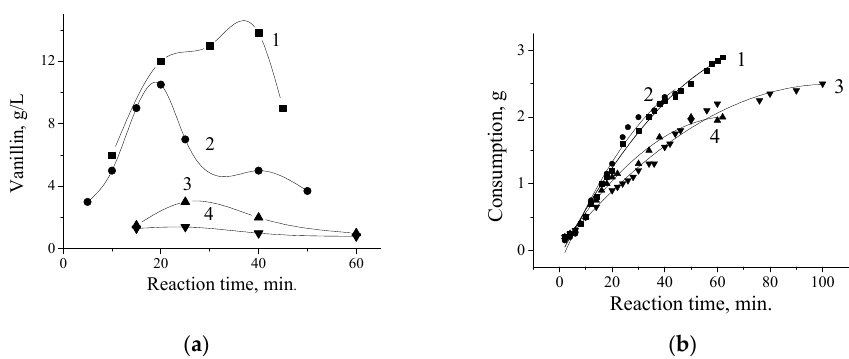
Figure 3. The influence of alkali concentration and pH on vanillin yield ( a ) and oxygen consumption ( b ) in lignosulfonate oxidation at 160 °C. Curve numbers correspond to the row numbers in Table 4 (1–5: 120 g/L NaOH; 2–6: 80 g/L NaOH; 3–7: 40 g/L NaOH + 300 g/L K 2 CO 3 , pH 10.5–10.8; 4–8: 300 g/L K 2 CO 3 , pH 10.3–10.0) (see reference [43]). Table 4. The influence of catalysts and pH (measured at 20 °C) on initial oxygen consumption rate; and the parameters corresponding to peak vanillin concentrations. Oxidation of lignosulfonates. Unless otherwise noted, the content of the dry sulfite liquor components in reaction solutions 180 g/L, oxygen partial pressure 0.2 MPa, reaction solution volume 60 mL (see reference